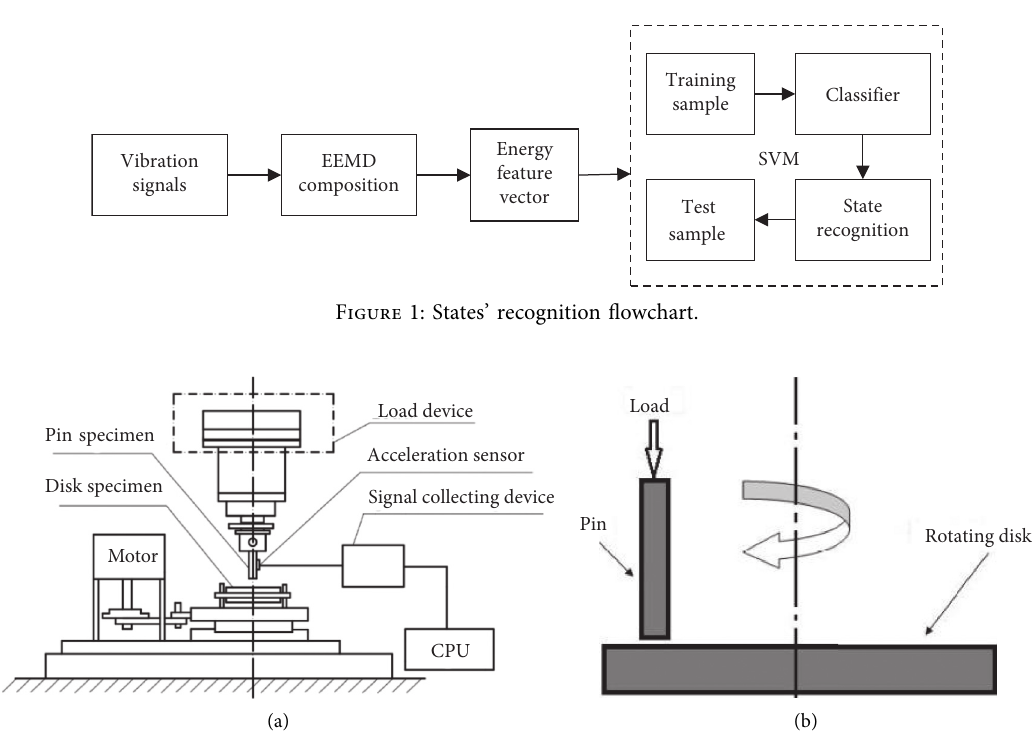
Figure 2: Schematic diagram of the UMT-3 tester. (a) Experiment device and (b) tribological pair.